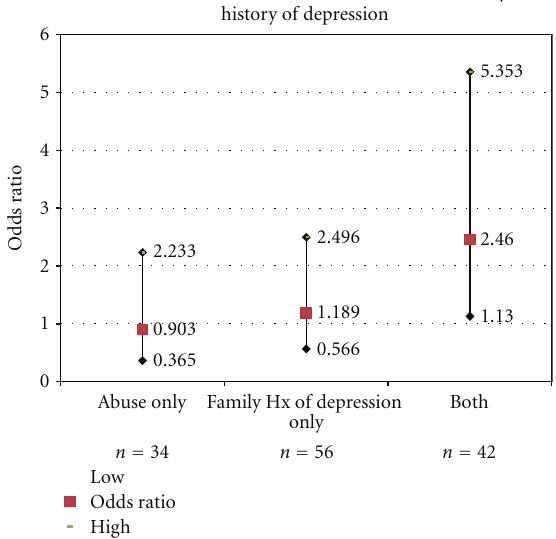
Figure 2: Odds ratios for risk of developing MDD in the context of a family history of Major Depressive Disorder and childhood